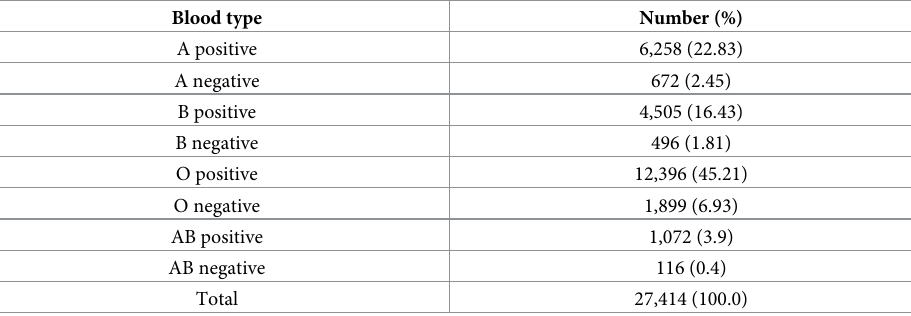
Table 1. ABO/Rh blood donation